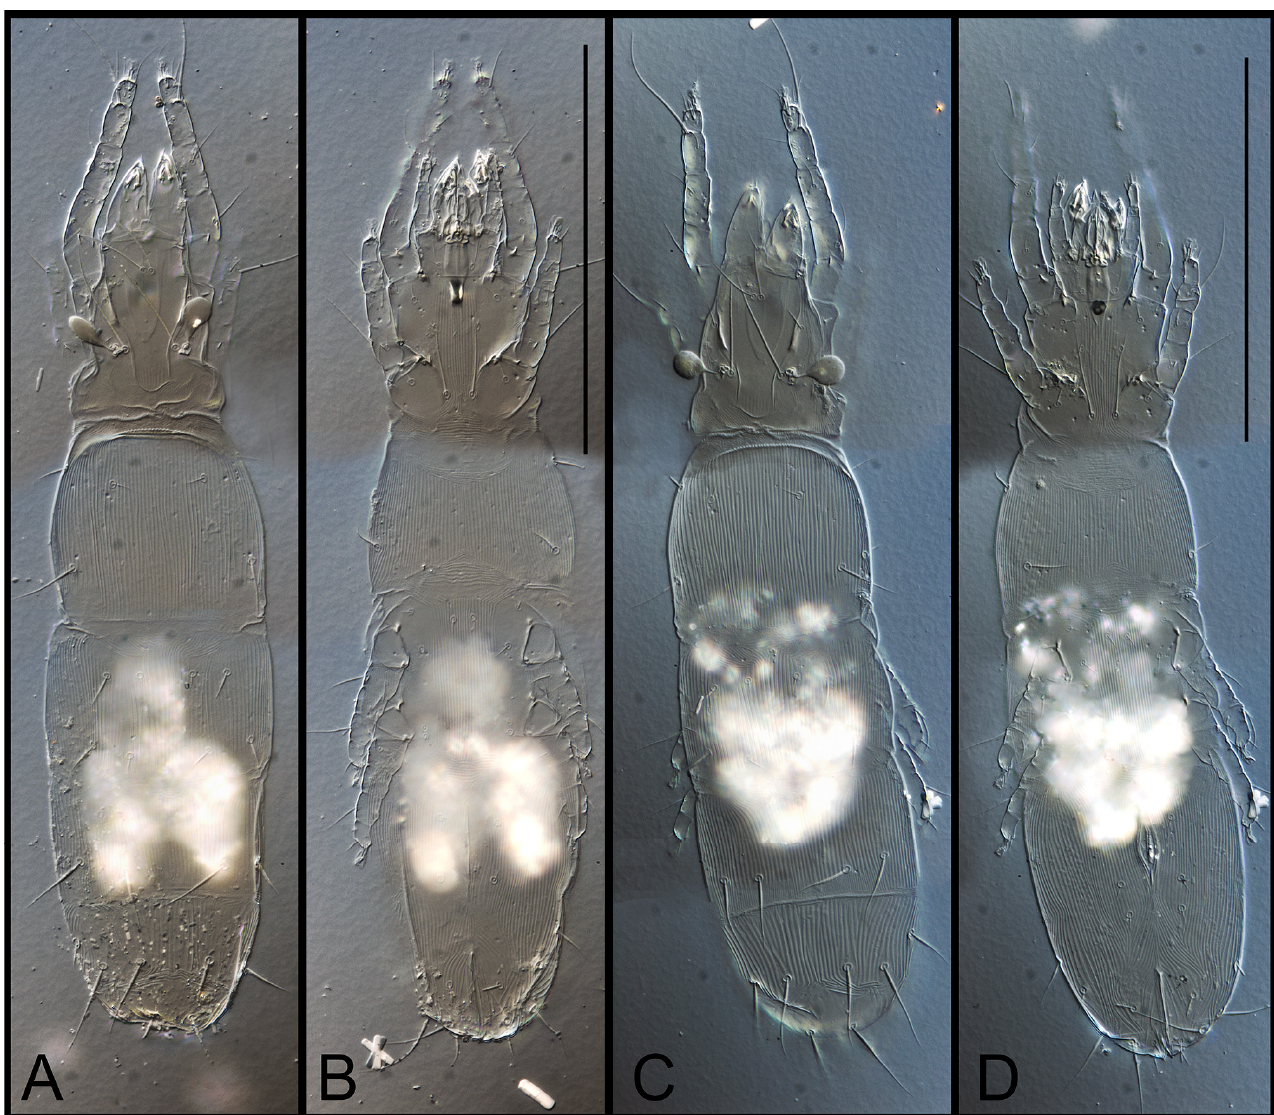
Figure 6. Paralycus daeira sp. n., deutonymph ( A , B ) and tritonymph ( C , D ), light microscope images: ( A , C )—dorsal view; ( B , D )—ventral view. Scale bar 100 µm.